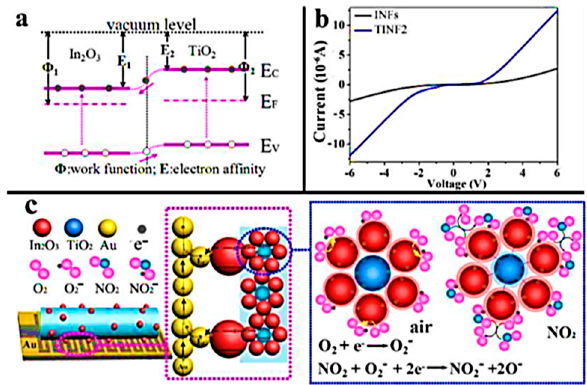
Figure 11. ( a ) Energy band diagram of In 2 O 3 and TiO 2 , EC: conduction band and EV: valence band; ( b ) I-V curves measured for INFs and TINF 2 thin film sensors in air at RT, which were treated at 110°C (the gate voltage Vg = 0.1); ( c ) The gas sensing reactions based on Schottky junction between Au electrode and In 2 O 3 beads. Reprinted with permission from Ref. [46] Copyright 2015 American Chemical Society.